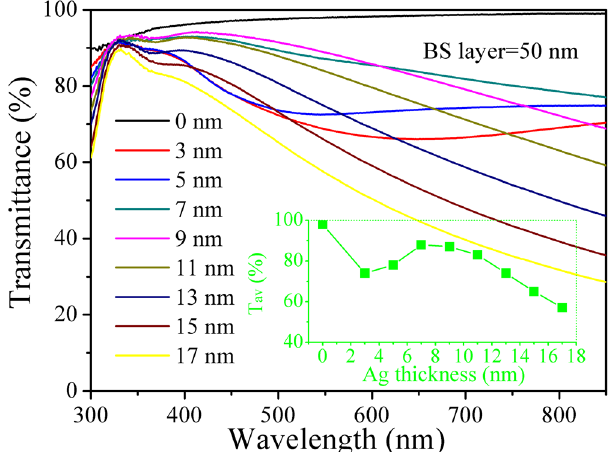
Figure 1. Transmittance spectra of BS/Ag/BS multilayer flexible thin films with various Ag mid–layer thicknesses. Inset is the average optical transmittance in the visible range (380 nm~780 nm) of the multilayer flexible thin films as a function of Ag mid-layer